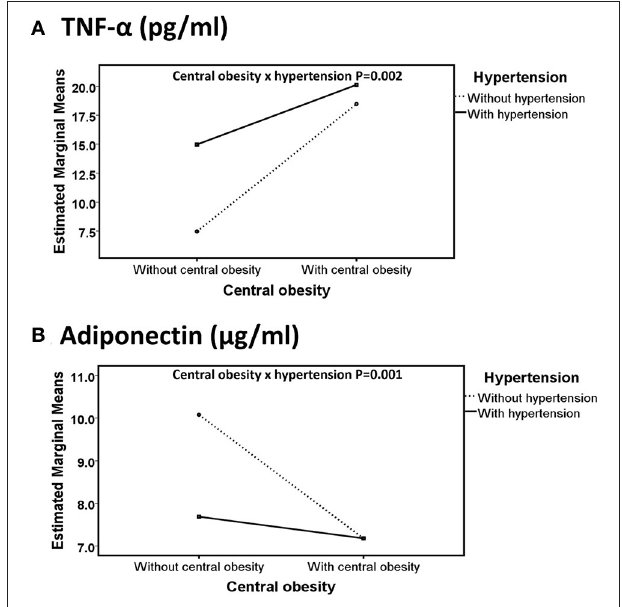
(B) in Hong Kong Chinese women categorized into four groups, including (1) Non-central obese subjects with normal blood pressure (NO_NBP; n = 105), (2) Non-central obese subjects with hypertension (NO_HBP; n = 102), (3) Central obese subjects with normal blood pressure (O_NBP; n = 74), and (4) Central obese subjects with hypertension (O_HBP; n = 106). Subjects with hypertension were defined as having systolic blood pressure ≥ 140 mmHg and diastolic blood pressure ≥ 90 mmHg, and subjects with central obesity were defined as having a waist circumference ≥ 80cm. The data are expressed in estimated marginal